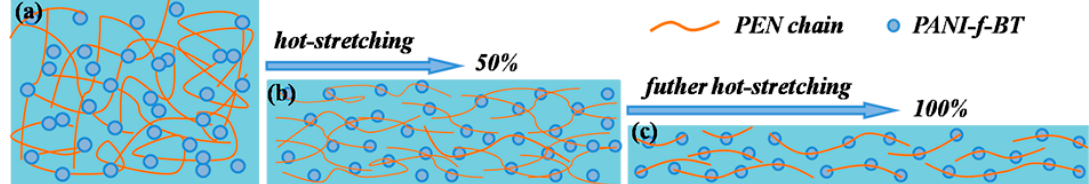
Figure 5. The theoretical model of the evolution process of inner network during uniaxial stretching: ( a ) the original composite film, the composite film hot-stretched by ( b ) 50% and (c) 100%.